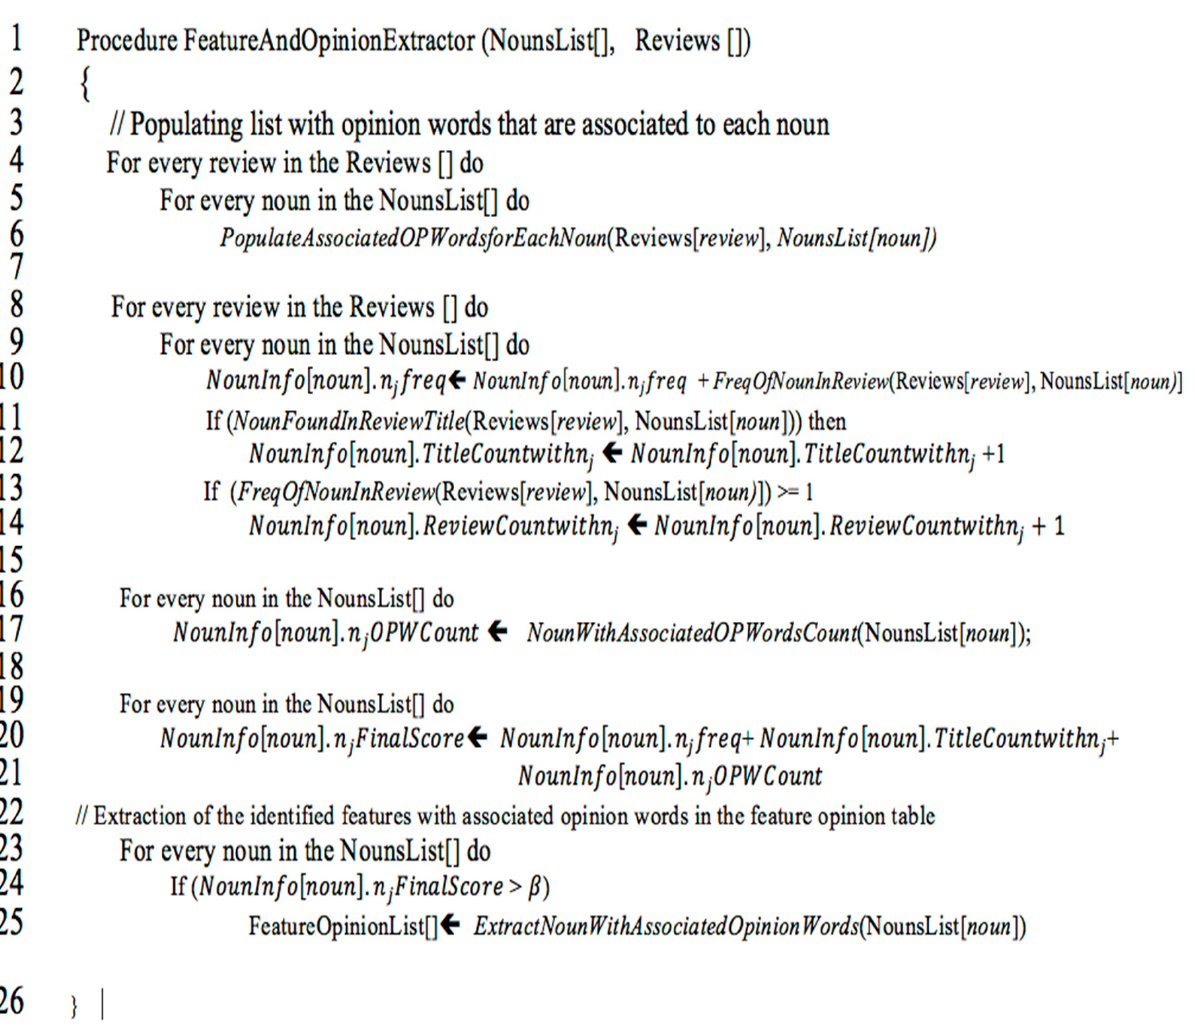
Figure 7. Algorithm for identifying potential features with associated opinion words.